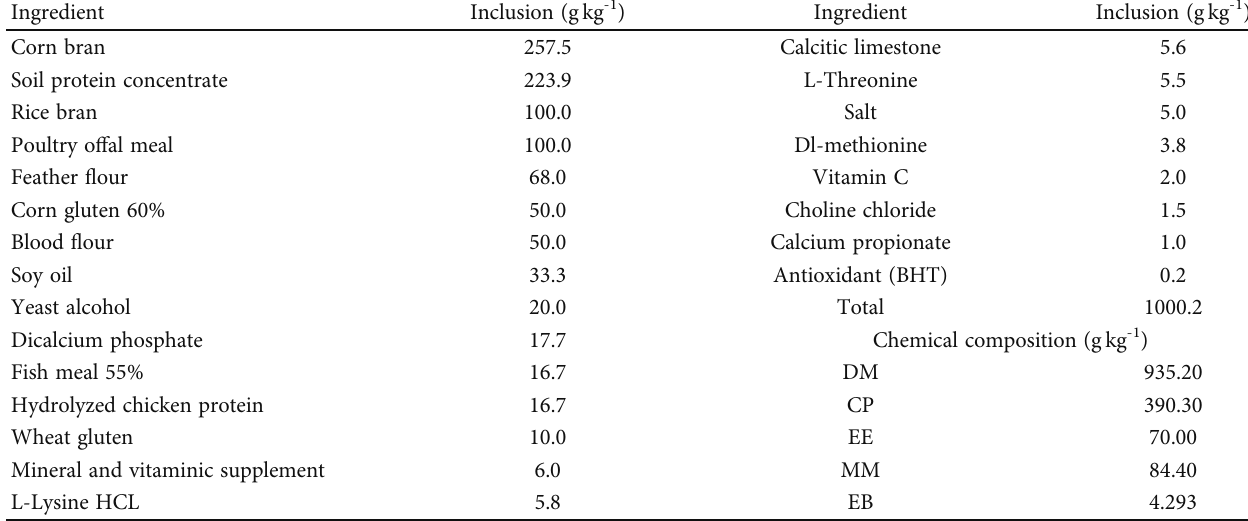
Table 1: Formulation and bromatological composition of feeds o ff ered to Nile tilapia fi ngerlings ( Oreochromis niloticus ). Ingredient Inclusion (g kg -1 ) Corn